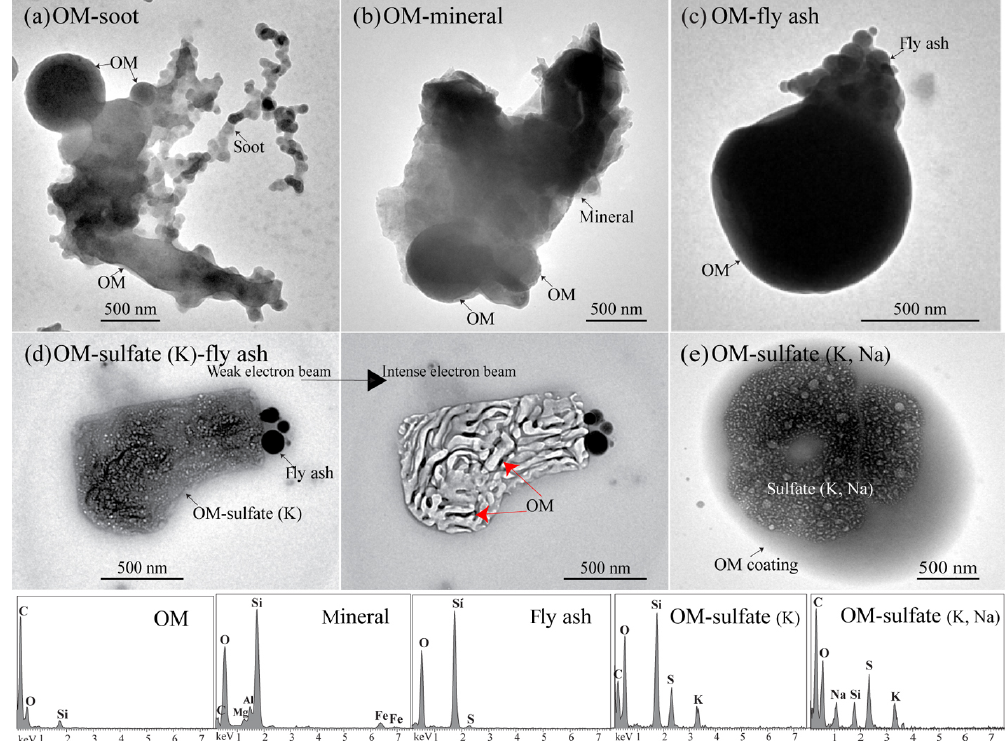
Figure 5. Typical TEM images of OM internally mixed particles (a) a spherical OM particle attached to a soot particle, (b) a near-spherical OM particle attached to a mineral particle, (c) fly ash particles attached to a near-spherical OM particle, (d) OM mixed with sulfate (K)-fly ash particle and its sublimed particle under strong electron beam, and (e) OM as a coating mixed with a sulfate (K, Na) particle. The element compositions in OM, mineral, fly ash, and sulfate particles were measured by the TEM/EDX.